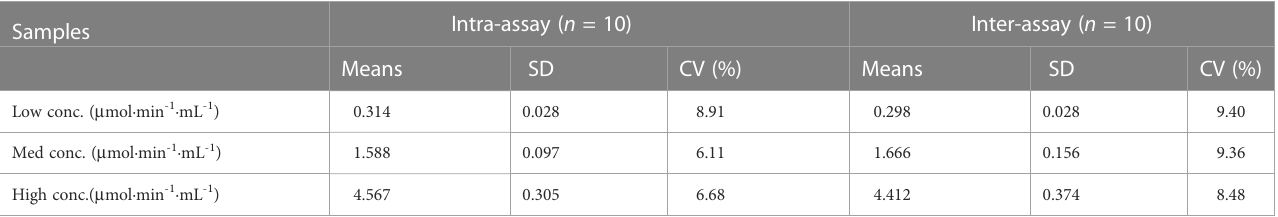
TABLE 3 Precision tests of C1s activity assay.